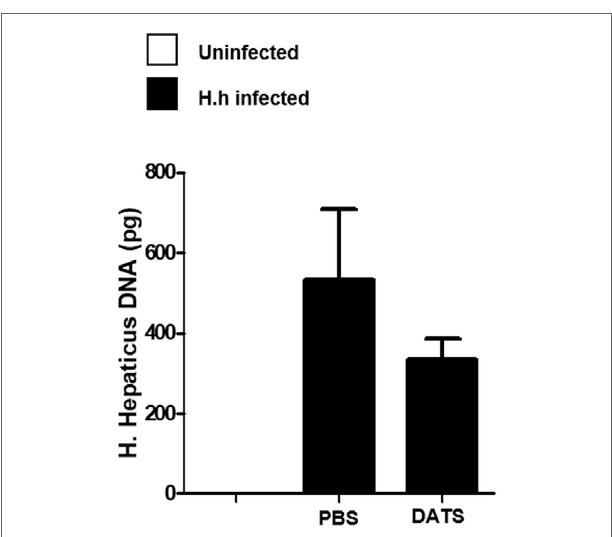
FigUre 4 | DATS does not affect Helicobacter hepaticus ( Hh ) colonization levels. Quantification of Hh DNA in cecum content samples from healthy mice and from 6 weeks Hh -infected mice treated with DATS or vehicle (PBS) by using a real-time PCR assay. Data are shown as mean ± SEM ( n = 5 per group).